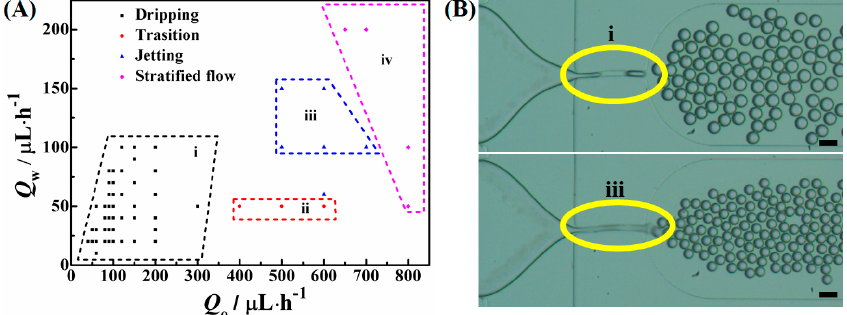
Figure 3. ( A ) Diagram of the microdroplets formation modes as a function of volume flow rates of oil and water phase. The modes were divided into (i) dripping-flow, (ii) transition-flow (from dripping to jetting), (iii) jetting-flow and (iv) stratified-flow; ( B ) Optical microscopic images of microdroplets generation under dripping (i) and jetting (iii) mode. Scale bars are 50 μ m. Q o and Q w were 80 and 20 μ L·h − 1 for top image of ( B ), 500 and 150 μ L·h − 1 for bottom image of ( B ). Hexadecane with 2.7% ( w/v ) Span 80 and DI water were used as the oil and water phase, respectively, to generate the emulsion droplets through the same microfluidic device with w f = 25 μ m.